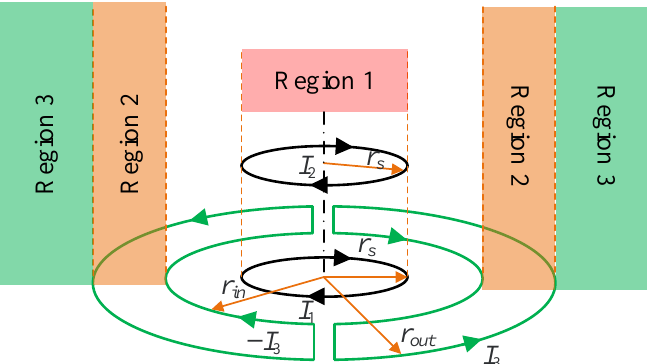
Figure 1. Double-coil active shielding structure. It is apparent from Figure 1 that each half-loop is equivalent to half of a circle, with its inner radius denoted by r in and outer radius denoted by r out . Two half-loops are installed around the transmitting coil, and the radius of the transmitting coil is r s ; thus, it is obvious that r in > r s . To facilitate the discussion at a later stage, the regions in Figure 1 are divided as follows: inside the transmitting coil, i.e., r < r s , is noted as region 1; excluding the transmitting coil part, the region inside the active shielding coil, i.e., r in < r < r out , is denoted as region 2; outside the active shielding coil, i.e., r > r out , is noted as region 3. Observing the direction of shielding coil currents in Figure 1, it can be seen that in region 3, the EMF generated by the two half-loops is in the opposite direction of the EMF generated by the transmitting coil, which creates a weakening effect on the total EMF in region 3. Moreover, in region 1, the EMF generated by the two shielding coils is consistent with the direction of the EMF of the transmitting coil. Compared with the traditional single shielding coil, the negative impact of the two half-loops on the performance of WPT system is reduced. It achieves a dual effect, reducing the EMF leakage of the WPT system while increasing the transmission efficiency.